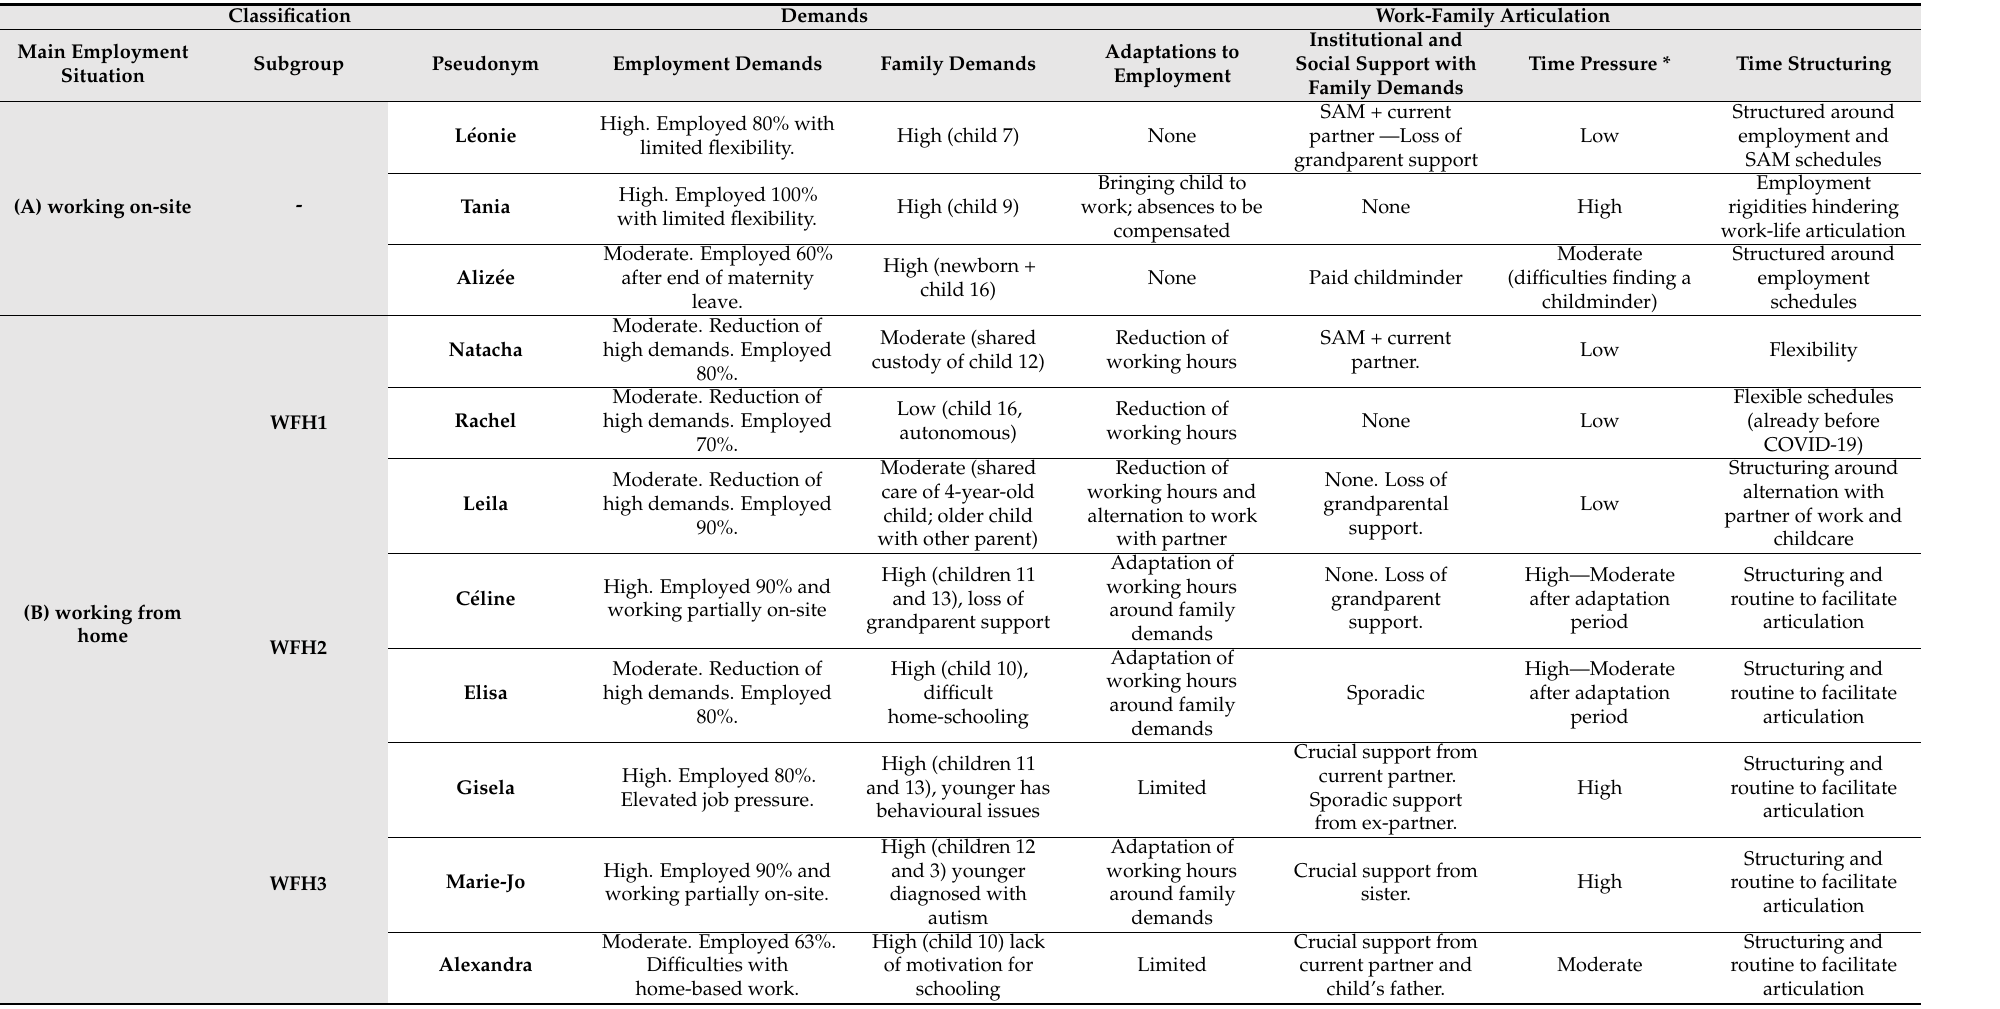
Table 2. Synthesis of findings—Classification of parents according to main patterns of work-family articulation and